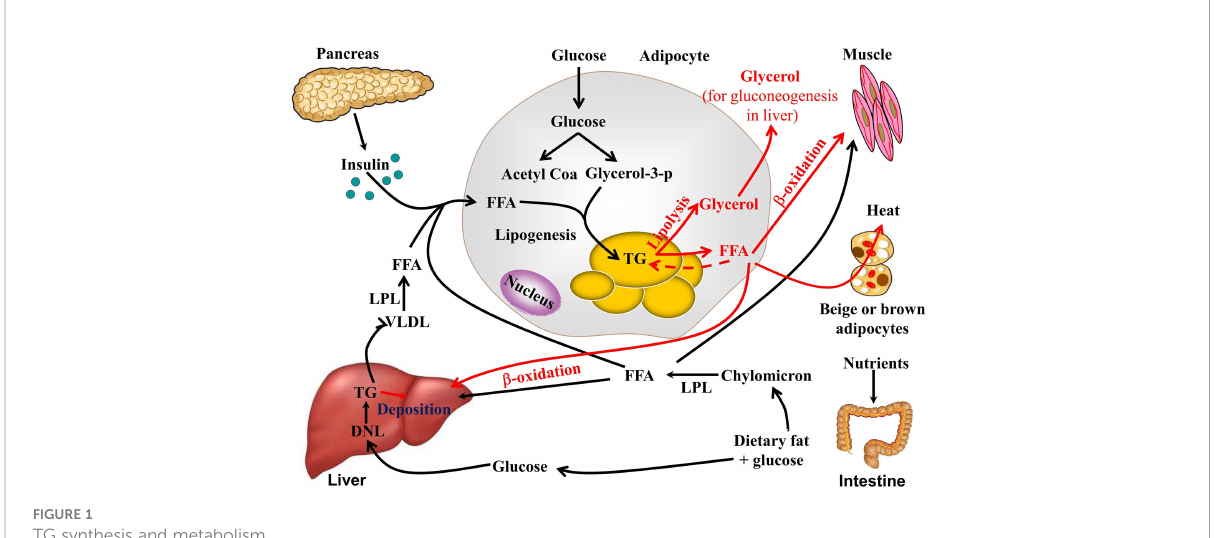
FIGURE 1 TG synthesis and